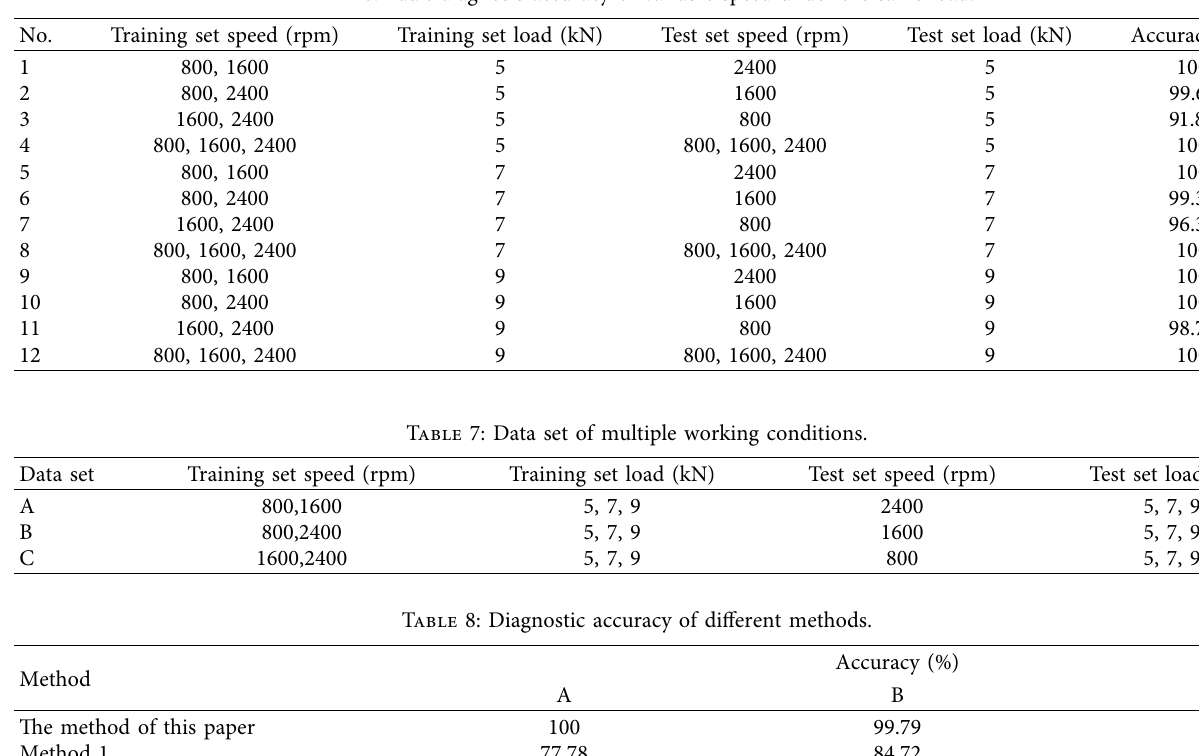
Table 6: Fault diagnosis accuracy of variable speed under the same